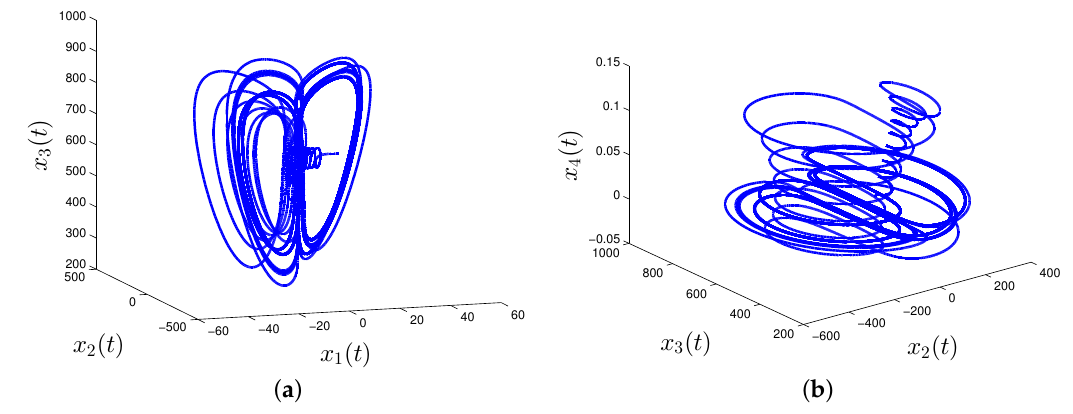
Figure 1. Chaotic attractor of system (1): ( a ) Phase space ( x 1 , x 2 , x 3 ) . ( b ) Phase space ( x 2 , x 3 , x 4 )